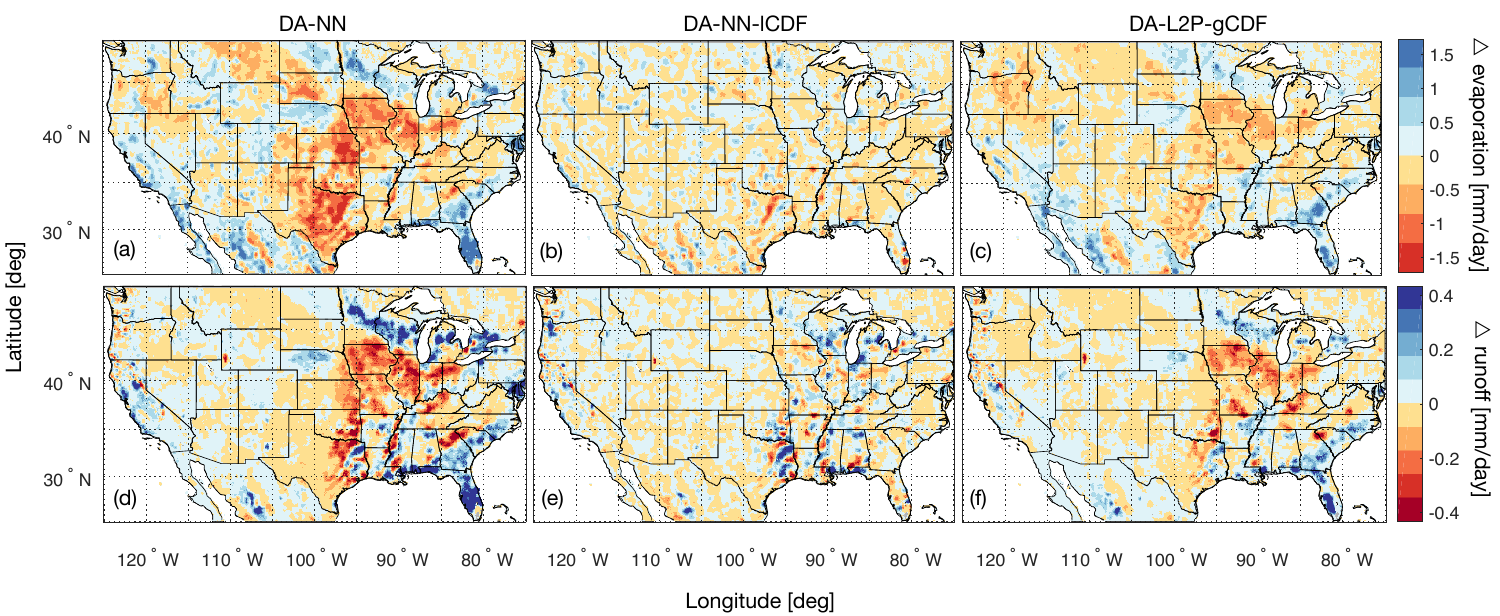
Figure 6. Average land evaporation difference—computed as DA minus OL for the period April 2015 to March 2017—for ( a ) DA-NN, ( b ) DA-NN-lCDF, and ( c ) DA-L2P-gCDF experiments. Panels ( d – f ) are the same, but for the difference of overland runoff with respect to the OL. Red colors indicate that the assimilation reduces the evaporation and runoff with respect to the